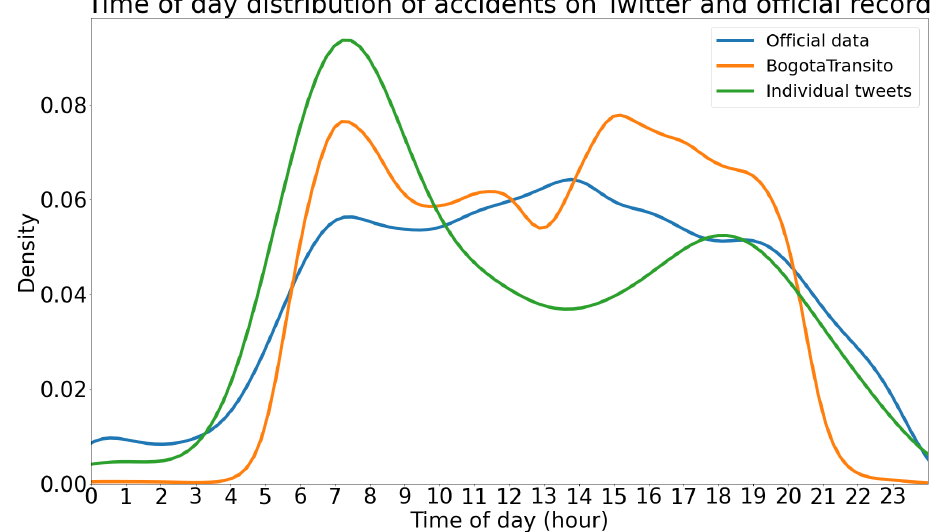
Figure 6. Distribution of accidents reported on Twitter and the Official Register by time of day.